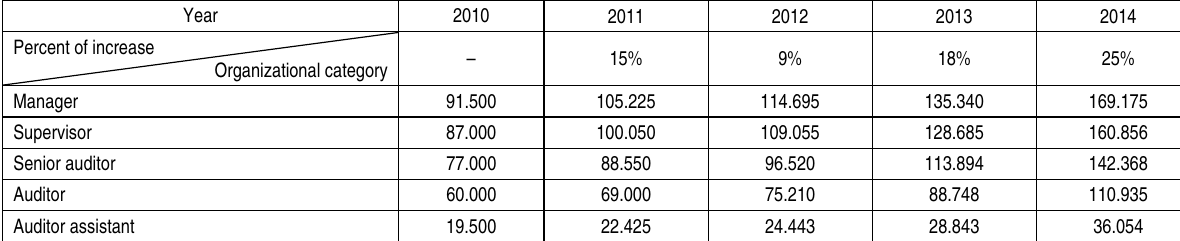
Table 11. Fee rate of each audit job category